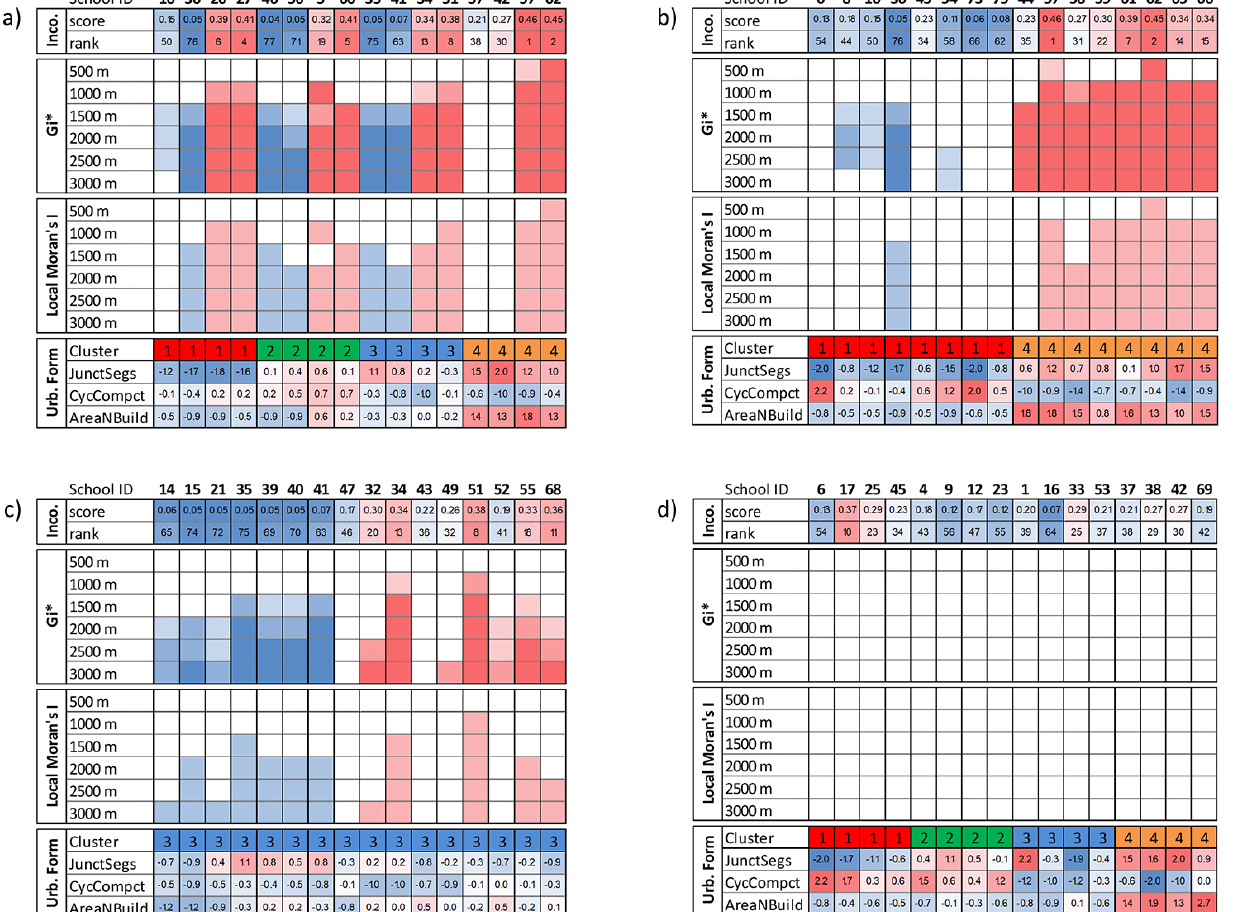
Figure 11. Four types of purposive samples: a) maximum variation sample, b) intensity, c) morphological homogeneity and d) socio-economic homogeneity